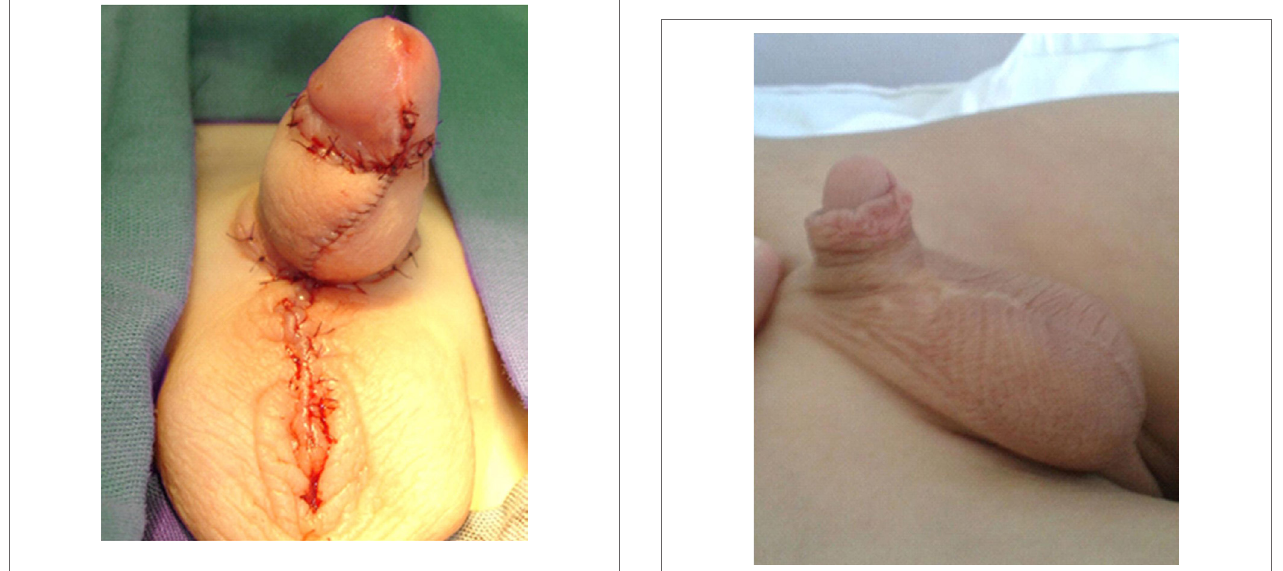
FigUre 6 | The same patient 4 years later.